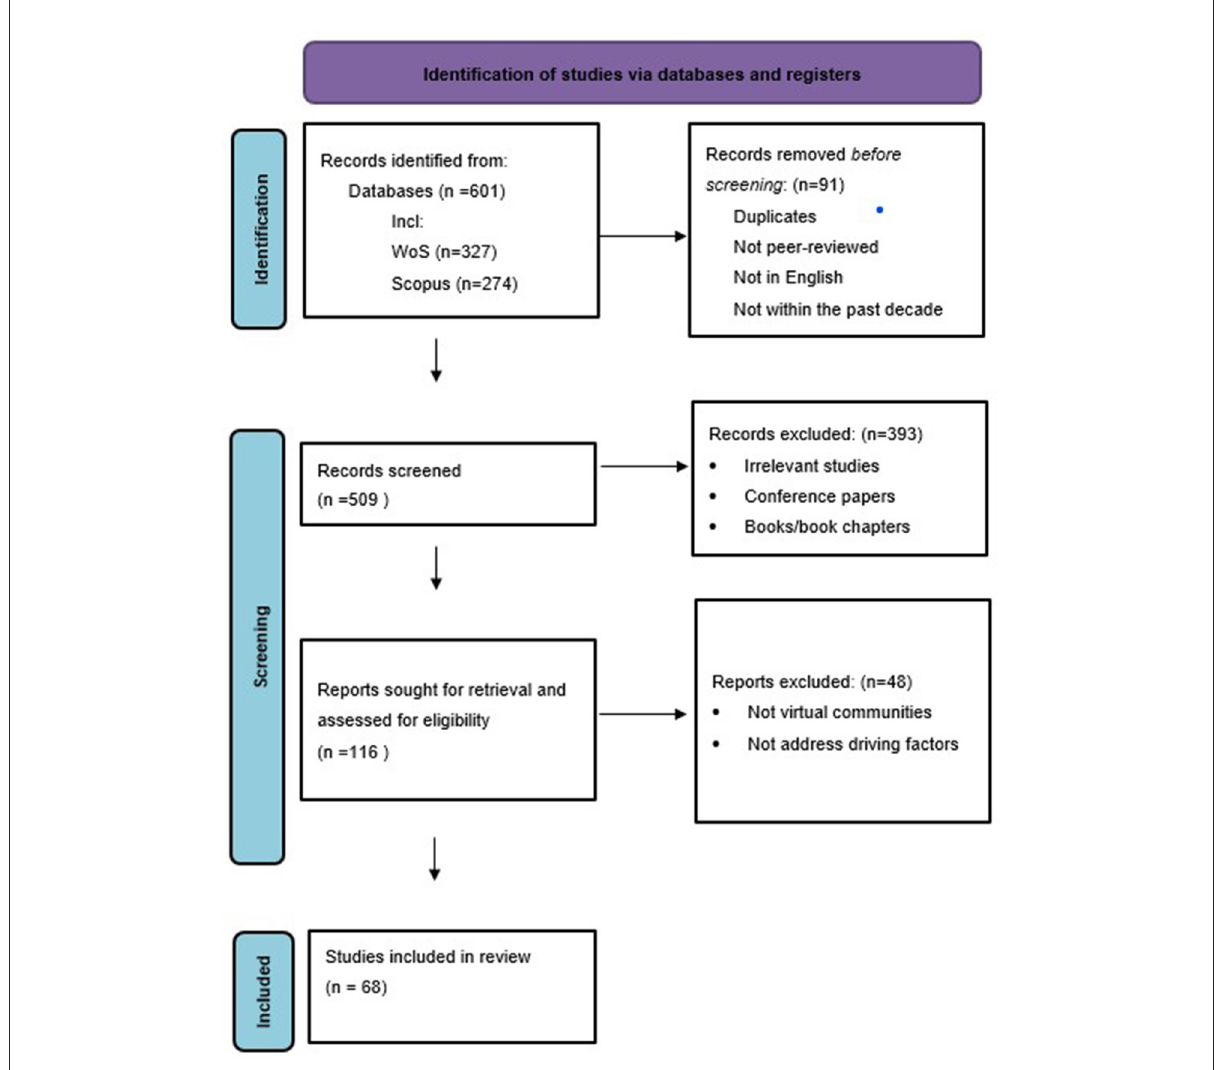
FIGURE1 PRISMA flow